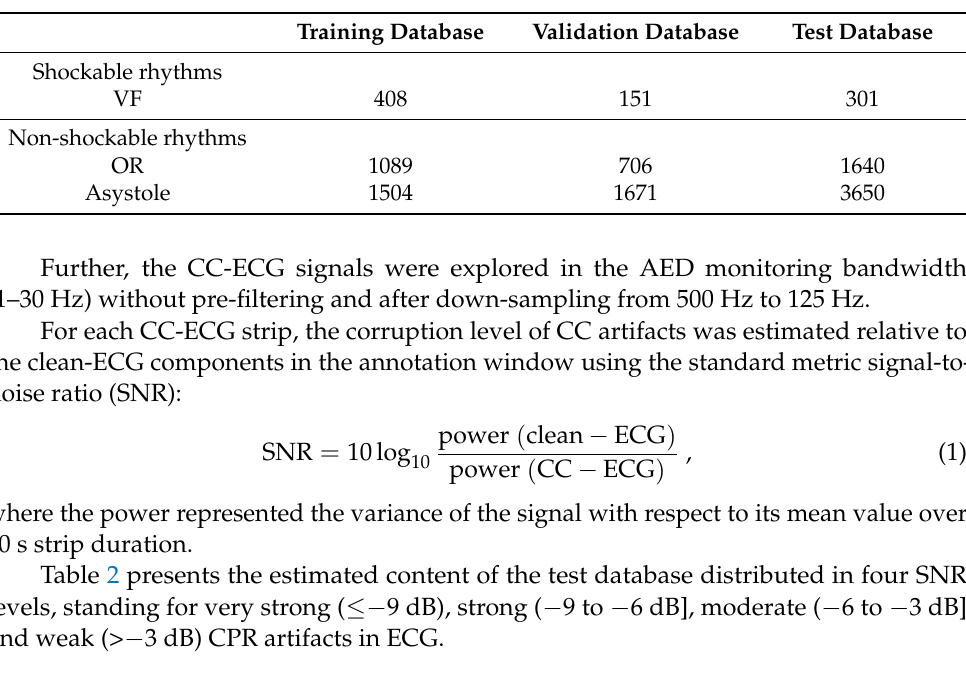
Table 2. Number of ECG strips in the test databases counted in four SNR